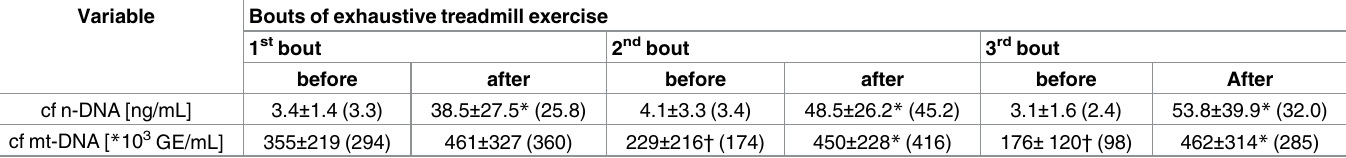
Results are expressed as mean ± standard deviation (and median in parentheses). Other details as for Table